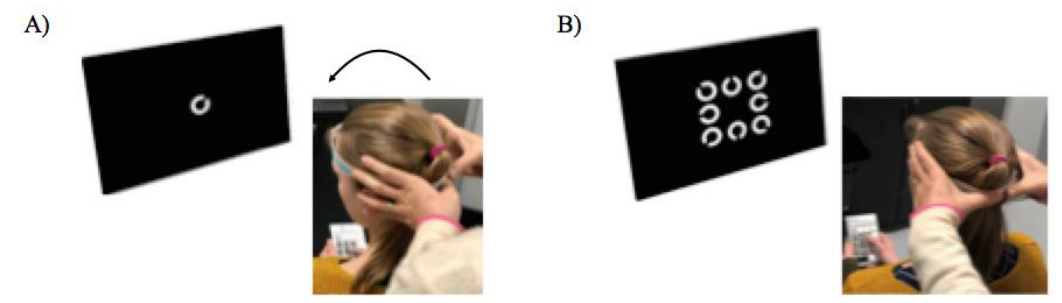
Figure 1. Experimental set up of the functional head impulse test (fHIT). ( A ): The child is positioned in front of a PC’s black screen (at 1.5 m) with a gyroscope fixed on the head by a head band. The child is invited to fixate on a small cross (not shown) presented on the center of the PC’s screen. A trained operator make head impulses in the lateral plane randomly to the right or to the left and a white Landolt C optotype appears eighty ms after head velocity surpasses 10 deg/s. ( B ): Then, eight different orientations of the Landolt C optotype are shown on the PC’s screen, and the child is instructed to select the correct position on a keypad.